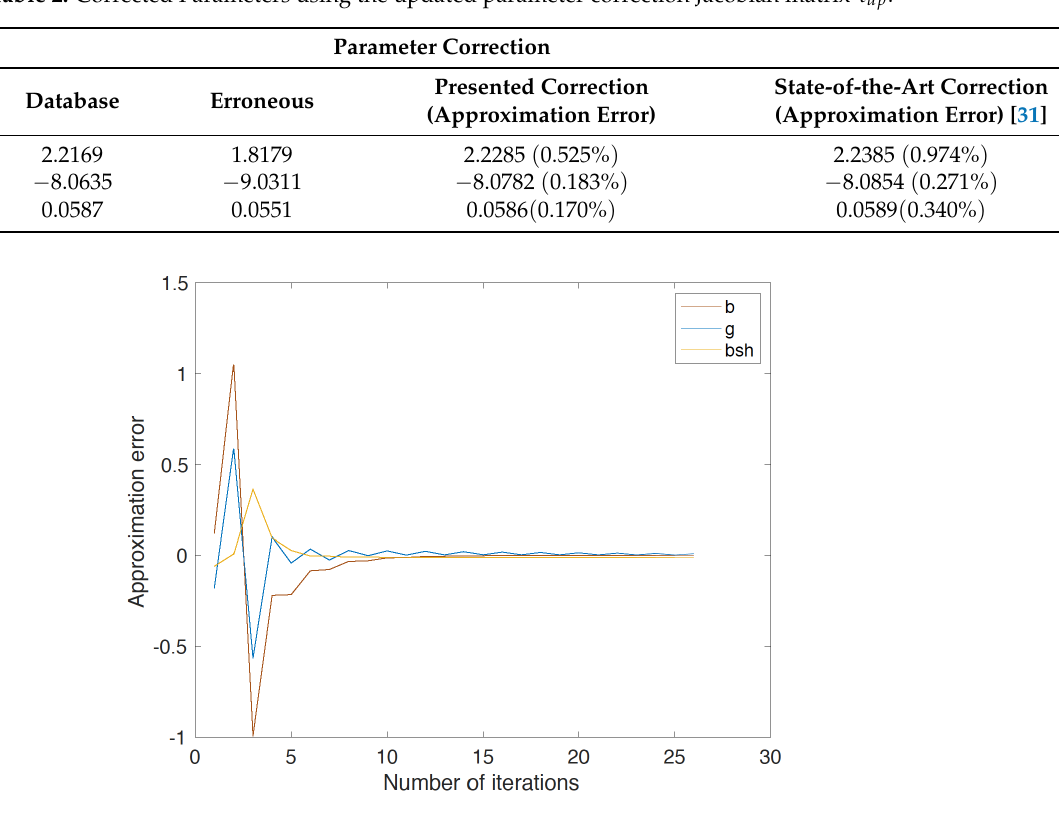
Table 2. Corrected Parameters using the updated parameter correction Jacobian matrix τ up .